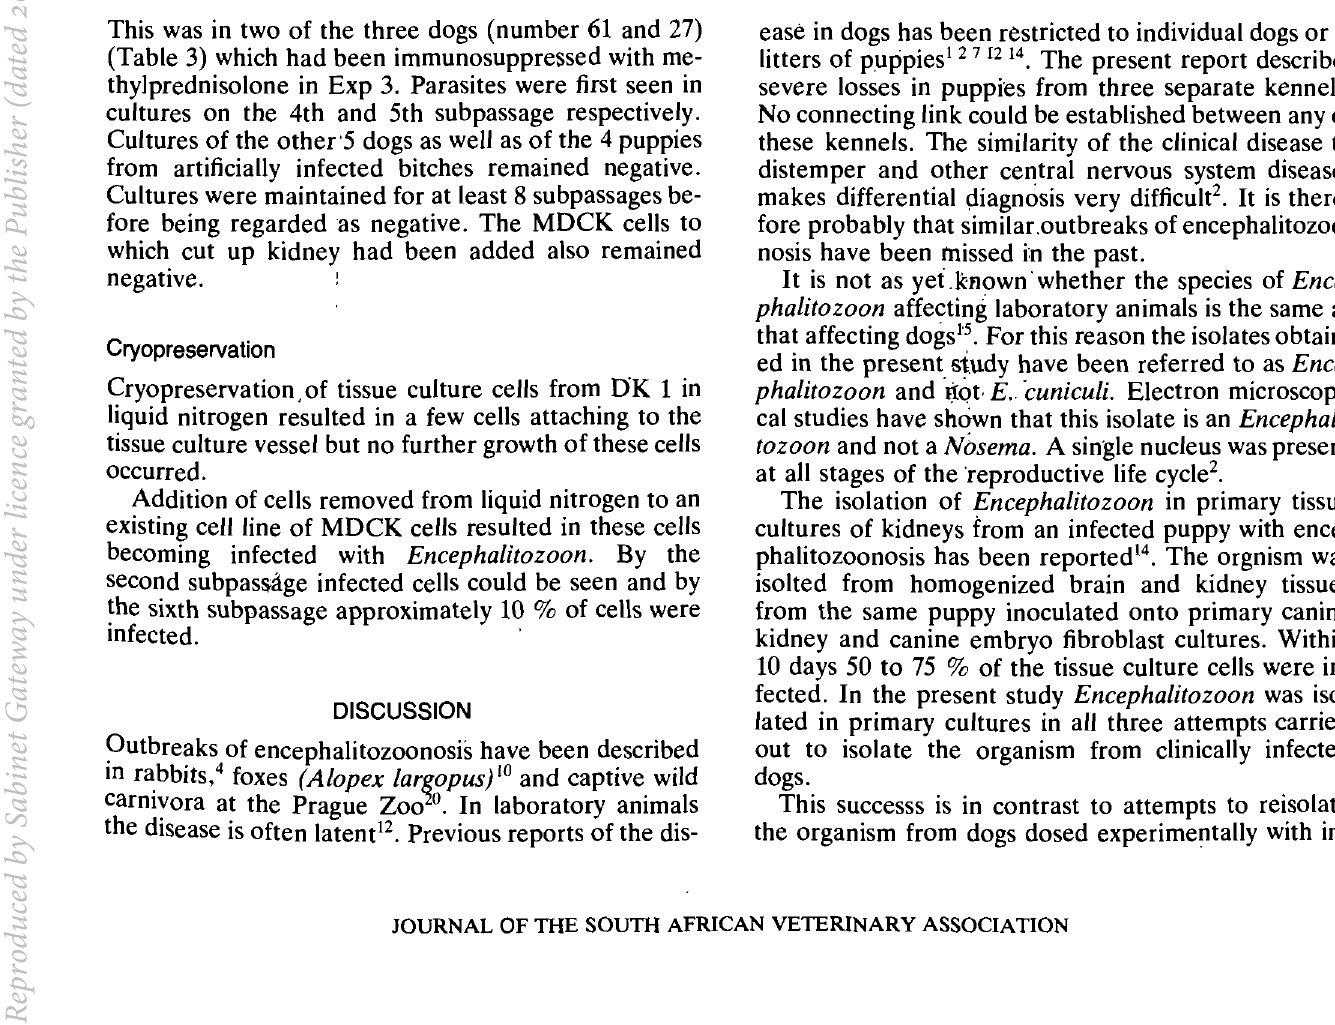
Table 3: ISOLATION OF ENCEPHALITOZOON FROM IMMUNOSUPPRESSED DOGS Age Dose Methyl- Number of spores Interval between